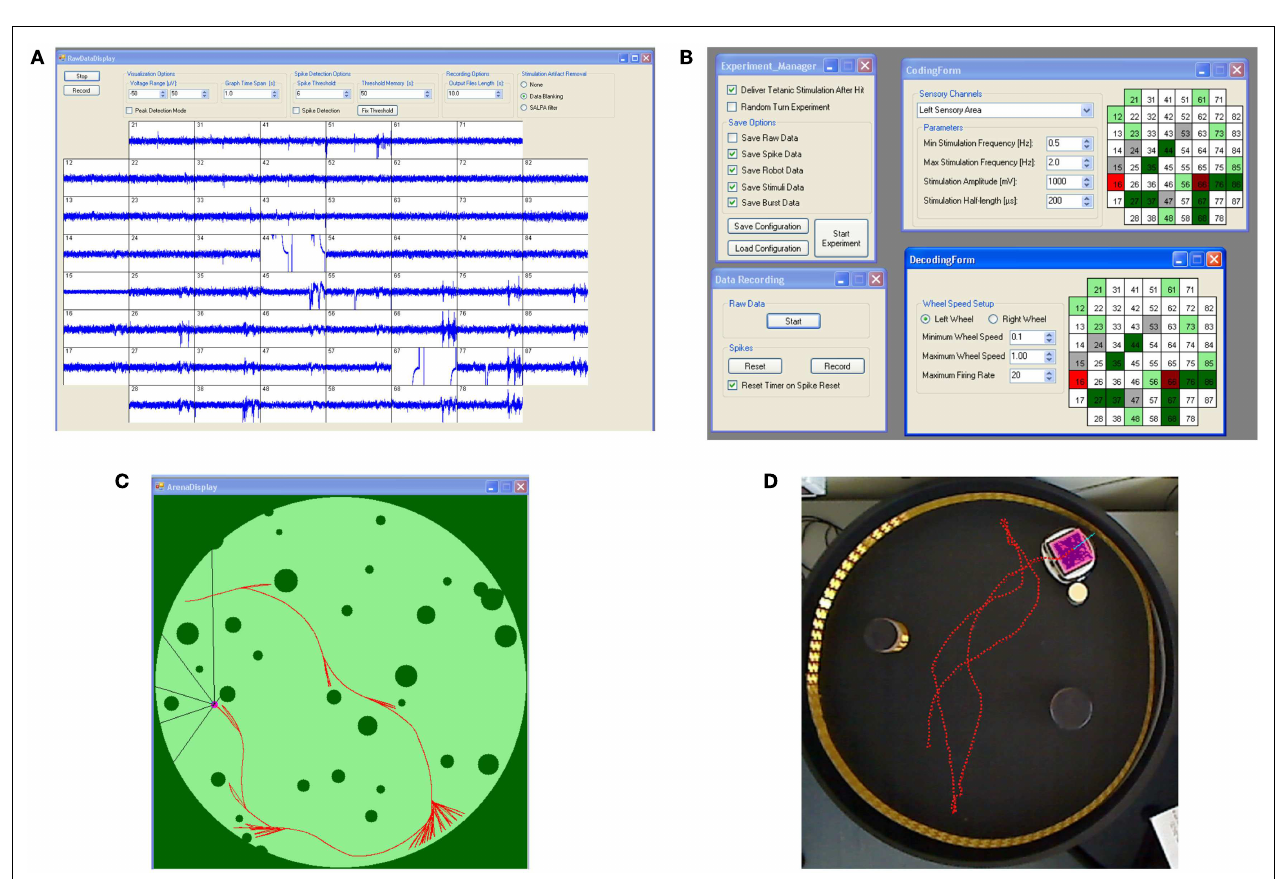
arena panel shows the environment of the arena. In the case of a virtual robot, this can also be used to draw the arena itself. (D) The physical robot inside the arena where two obstacles are placed.The dotted red line represents the trajectory of the robot inside the